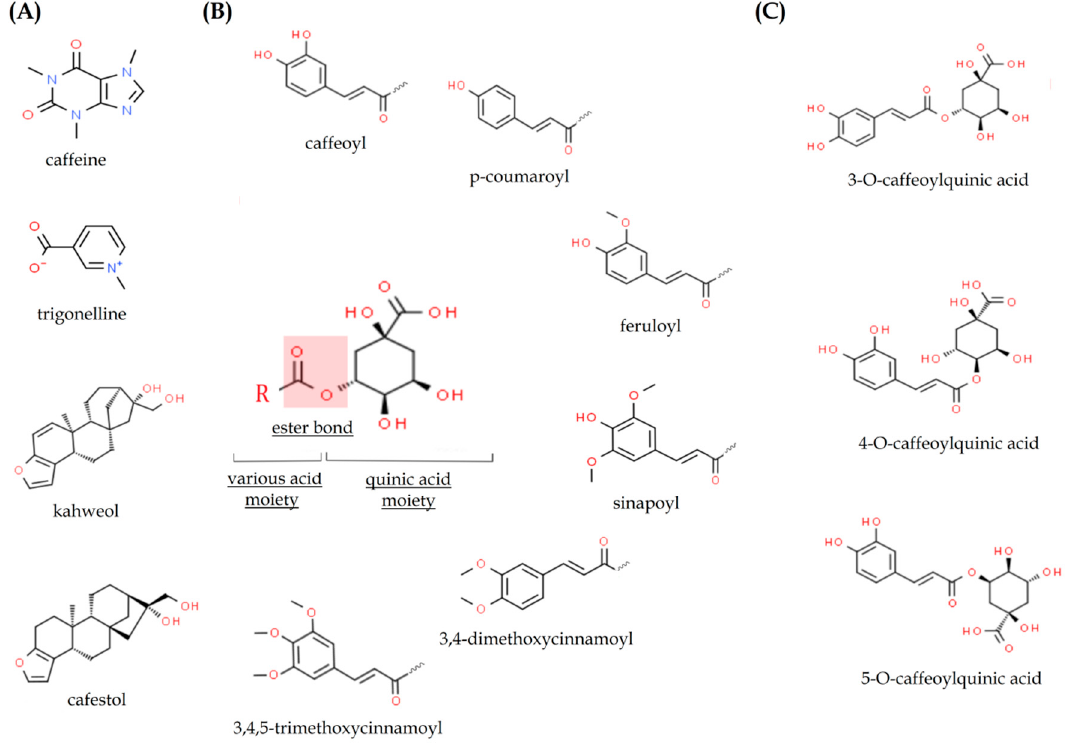
Figure 1. Structures of the most important bioactive compounds in coffee. ( A ) structures of key compounds not belonging to chlorogenic acids, ( B ) general structure of chlorogenic acids and the most important groups found in chlorogenic acids from coffee beans, ( C ) structures of caffeoylquinic acids found in coffee beans.